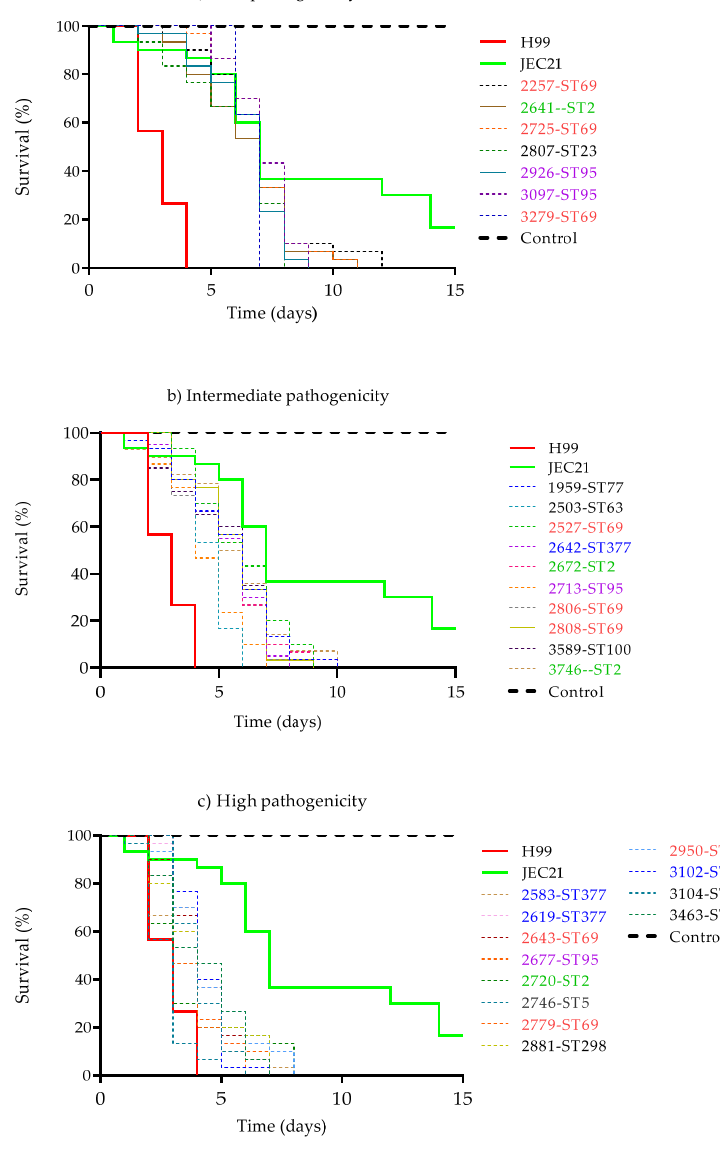
Figure 2. Survival curves of the 29 clinical isolates of C. neoformans with ( a ) low, ( b ) intermediate, and ( c ) high pathogenicity in G. mellonella. The most frequent STs are shown in green (ST2), red (ST69), purple (ST95) and blue (ST377). After injection with 1.5 × 10 8 cells/mL, Curves were constructed using the Kaplan–Meier method, and then the curves were compared using the log-rank (Mantel–Cox) test. The data are expressed as survival percentages. No larval death was observed in control larvae injected with an equivalent volume of